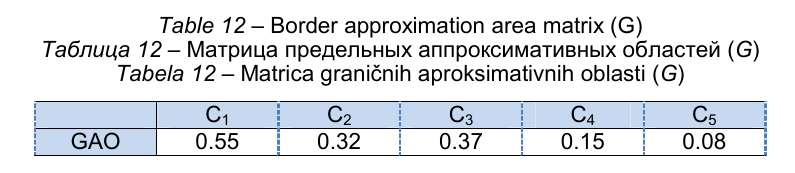
Table 12 – Border approximation area matrix (G) Таблица 12 – Матрица предельных аппроксимативных областей ( G )